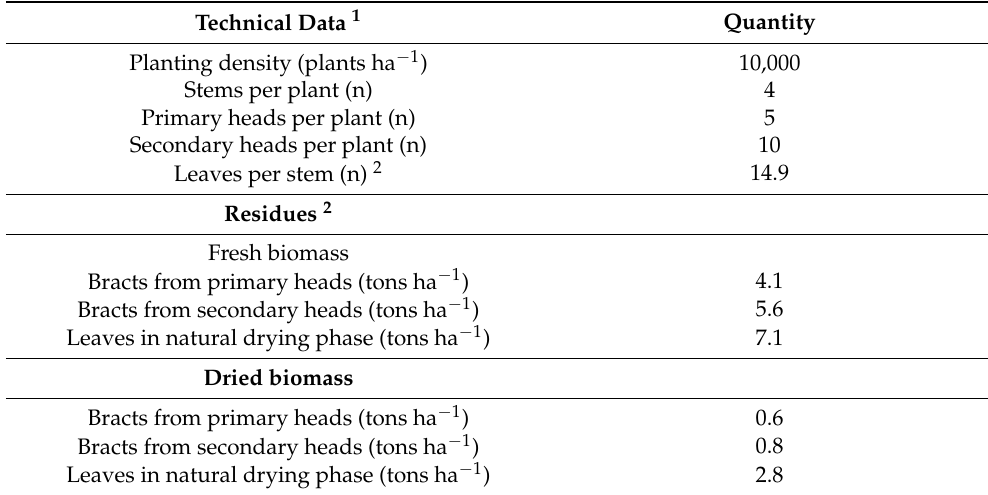
Table 4. Estimation of the residues from the cultivation of the artichoke Bianco of